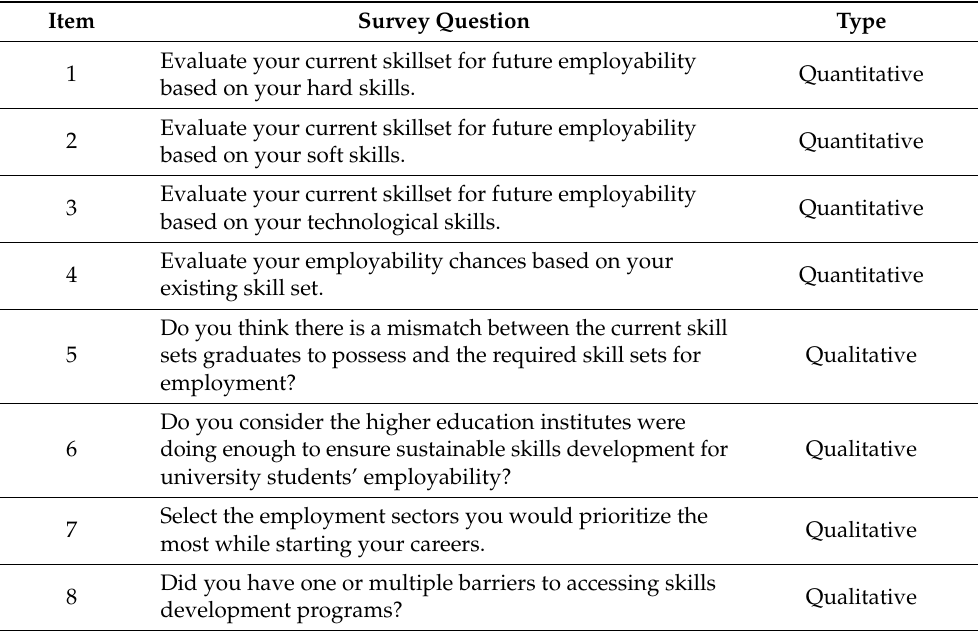
Table 2. Questions asked in the survey used for data